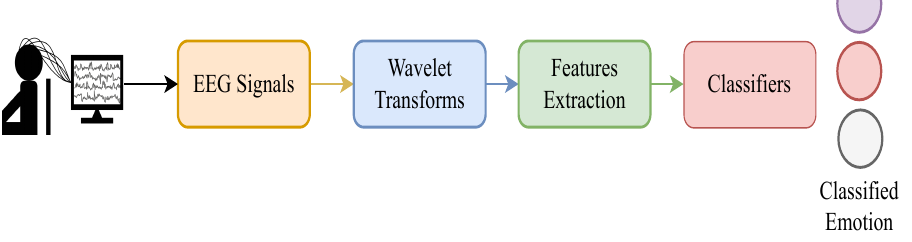
Figure 1. Overview of the proposed